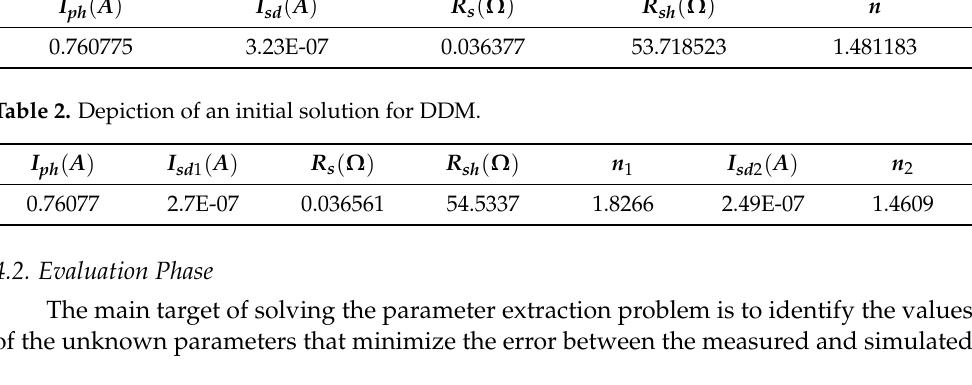
Figure 4. Flowchart of the jellyfish search optimizer (JSO).